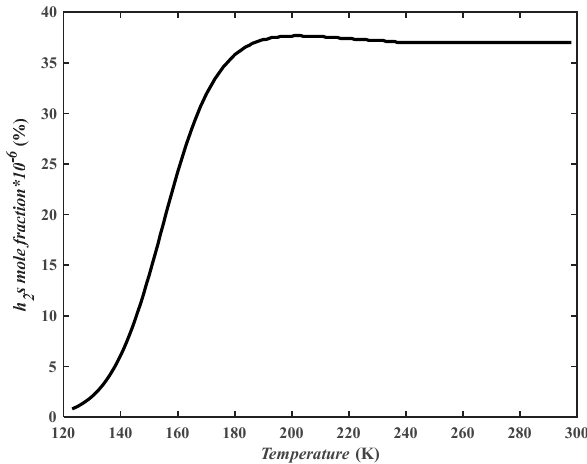
Figure 4. Variation of H 2 S mole fraction in stream 8 with the temperature of stream 6 in Figure 2.